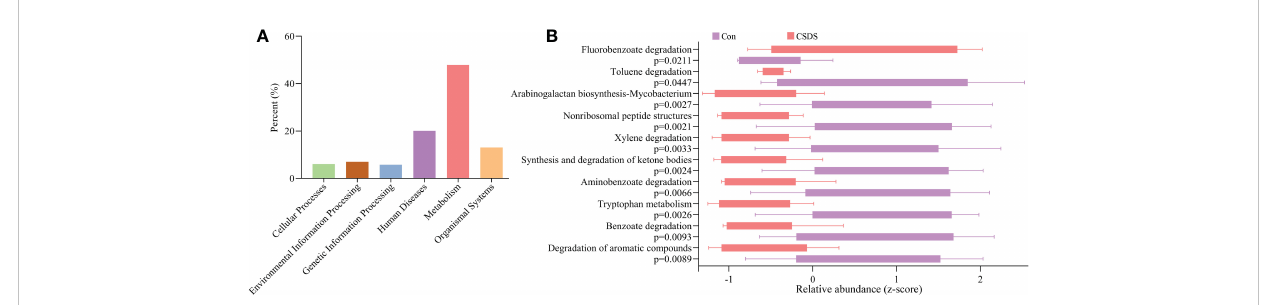
FIGURE 3 Functional predictions of the differential bacterial taxa. (A) the phylogenetic investigation of communities by reconstruction of unobserved states (PICRUSt) analysis showed that the metabolism category ranked the top, with a proportion of 47.92%; (B) in the metabolism category, ten signi fi cantly affected metabolism pathways were identi fi